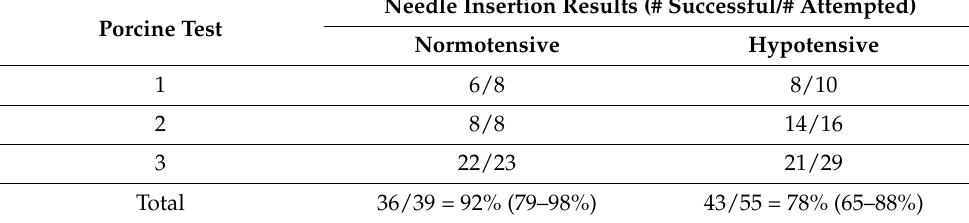
Table 4. AI-GUIDE needle insertion